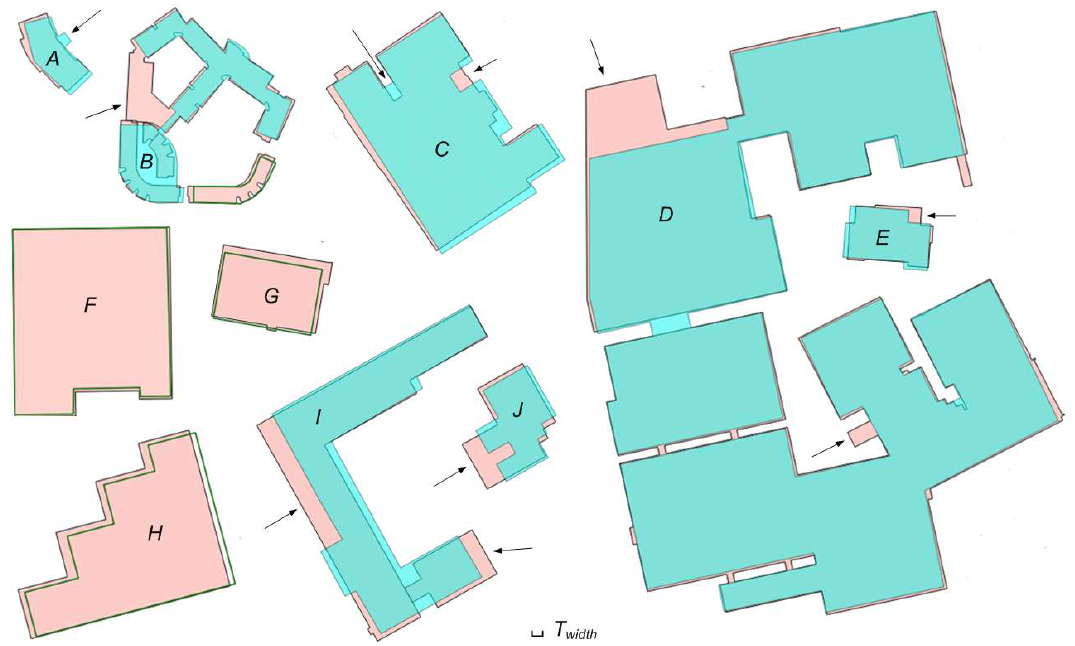
Figure 13. Detected changes (non-changes) as a result of the morphology analysis: situations are potentially modified in part (expansions and contractions are identified by small arrows).